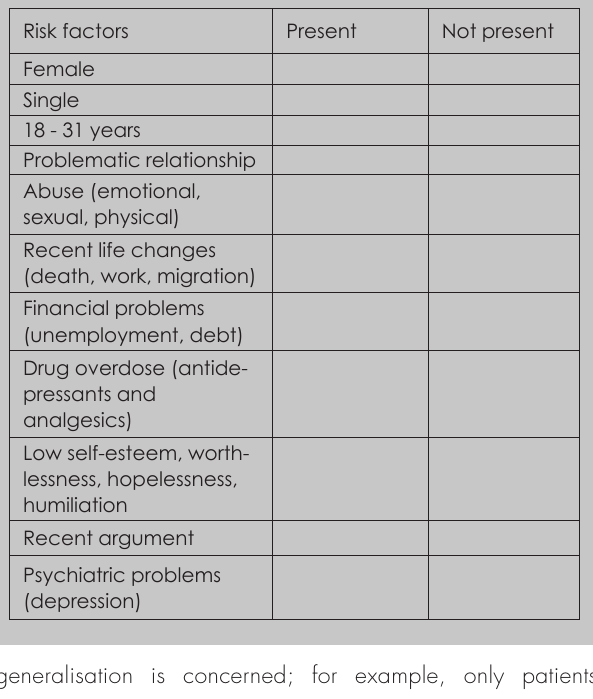
Table II. Predisposing factors in attempted suicide Risk